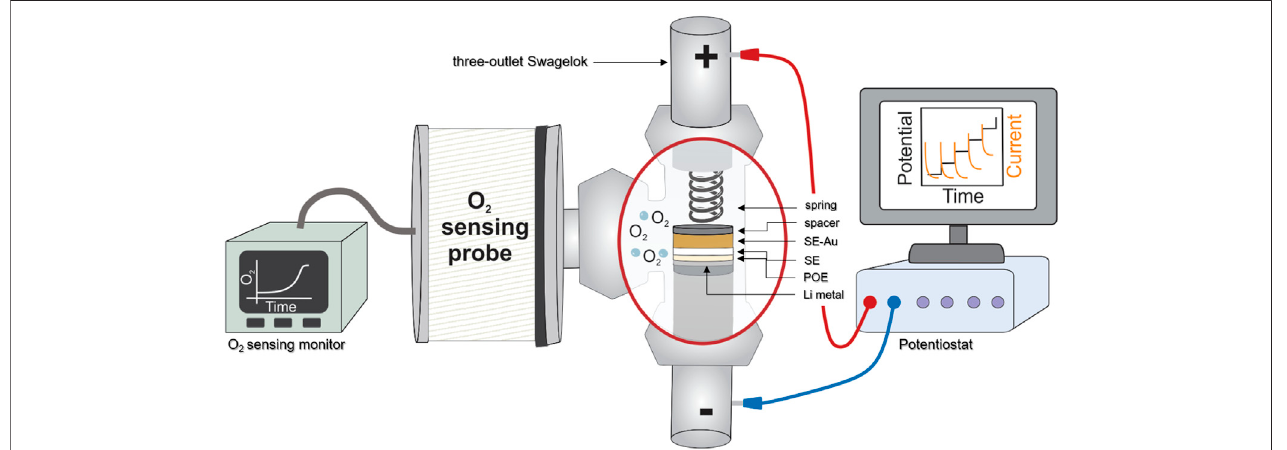
FIGURE 5 | Schematic representation of the setup combining O 2 sensing and PITT